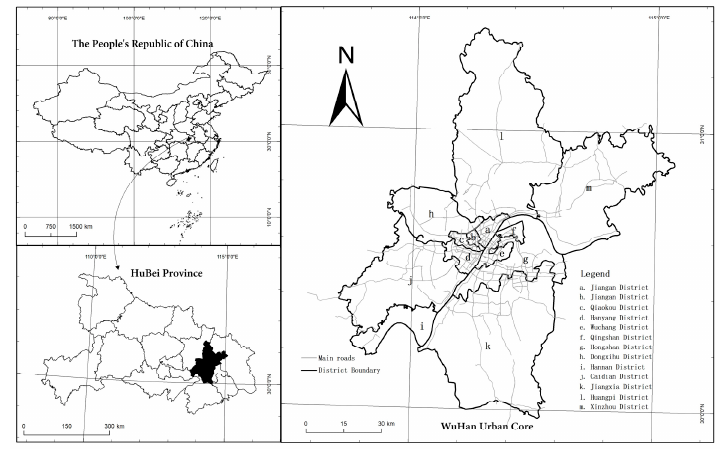
Figure 1. Research area.